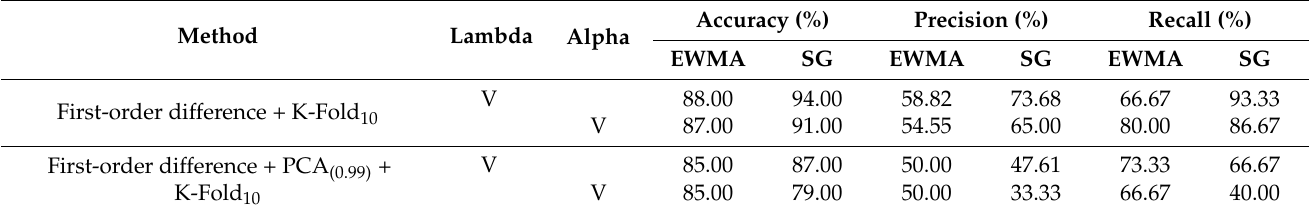
Table 7. Weighted binary cross